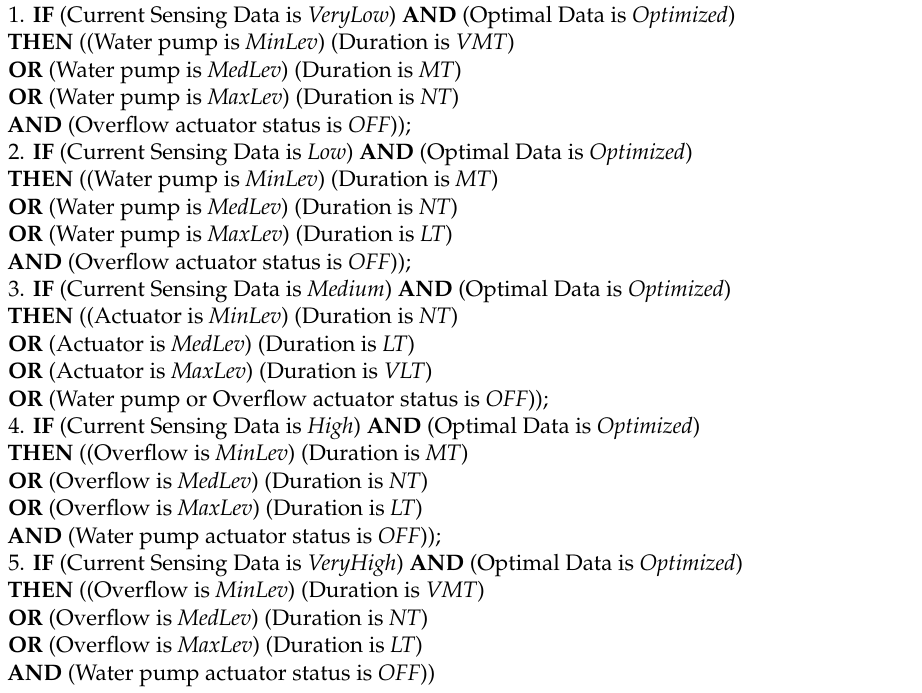
Table 4. Fuzzy logic inference rules for the hydroponics water